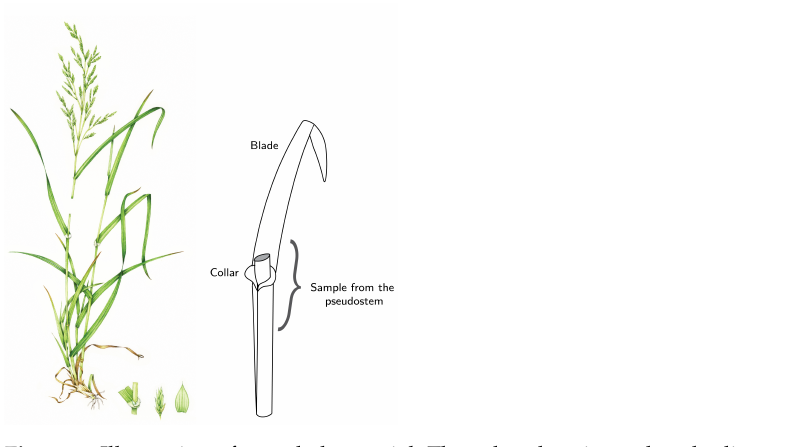
Figure 2. Illustration of sampled material. The colored art is used under license from Science Photo Library (https://www.sciencephoto.com, 25 September 2022 ). The line drawing is adapted from König et al.